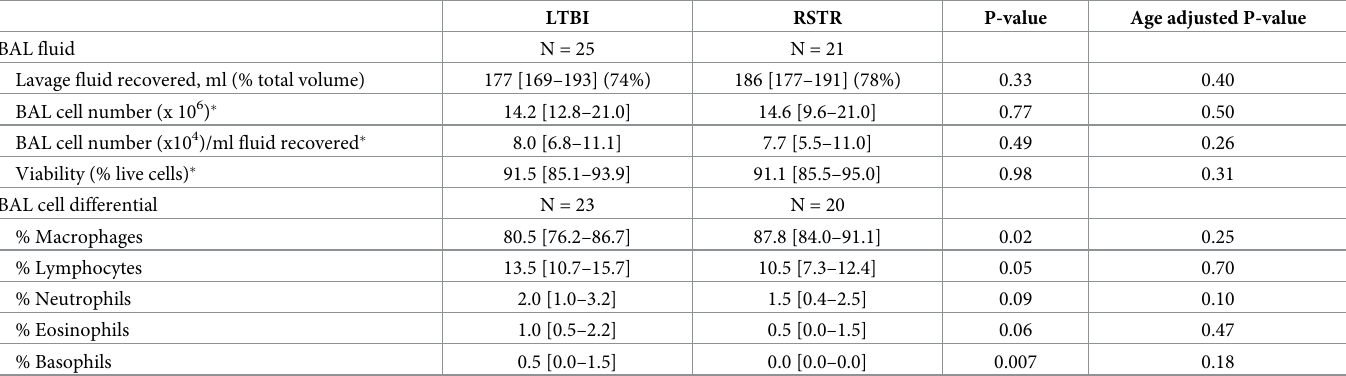
Table 2. BAL fluid recovery, cell yield and cell differentials of LTBI and RSTR